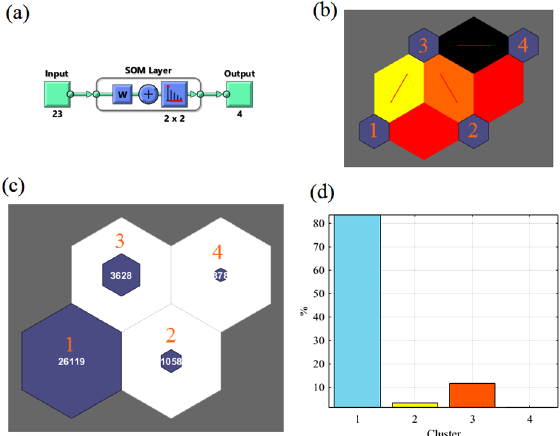
Figure 2. a – Architecture of SOM; b – SOM neighbor distance; c – SOM sample hits; d – Percentage of each cluster